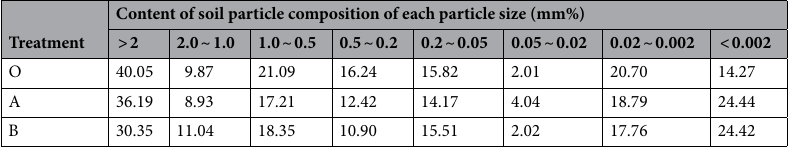
Table 3. Representative values of soil mechanical composition testing. O is bare slope, B is Prunella vulgaris combined with earthworm planting slope, A is Single planting prunella vulgaris slope.